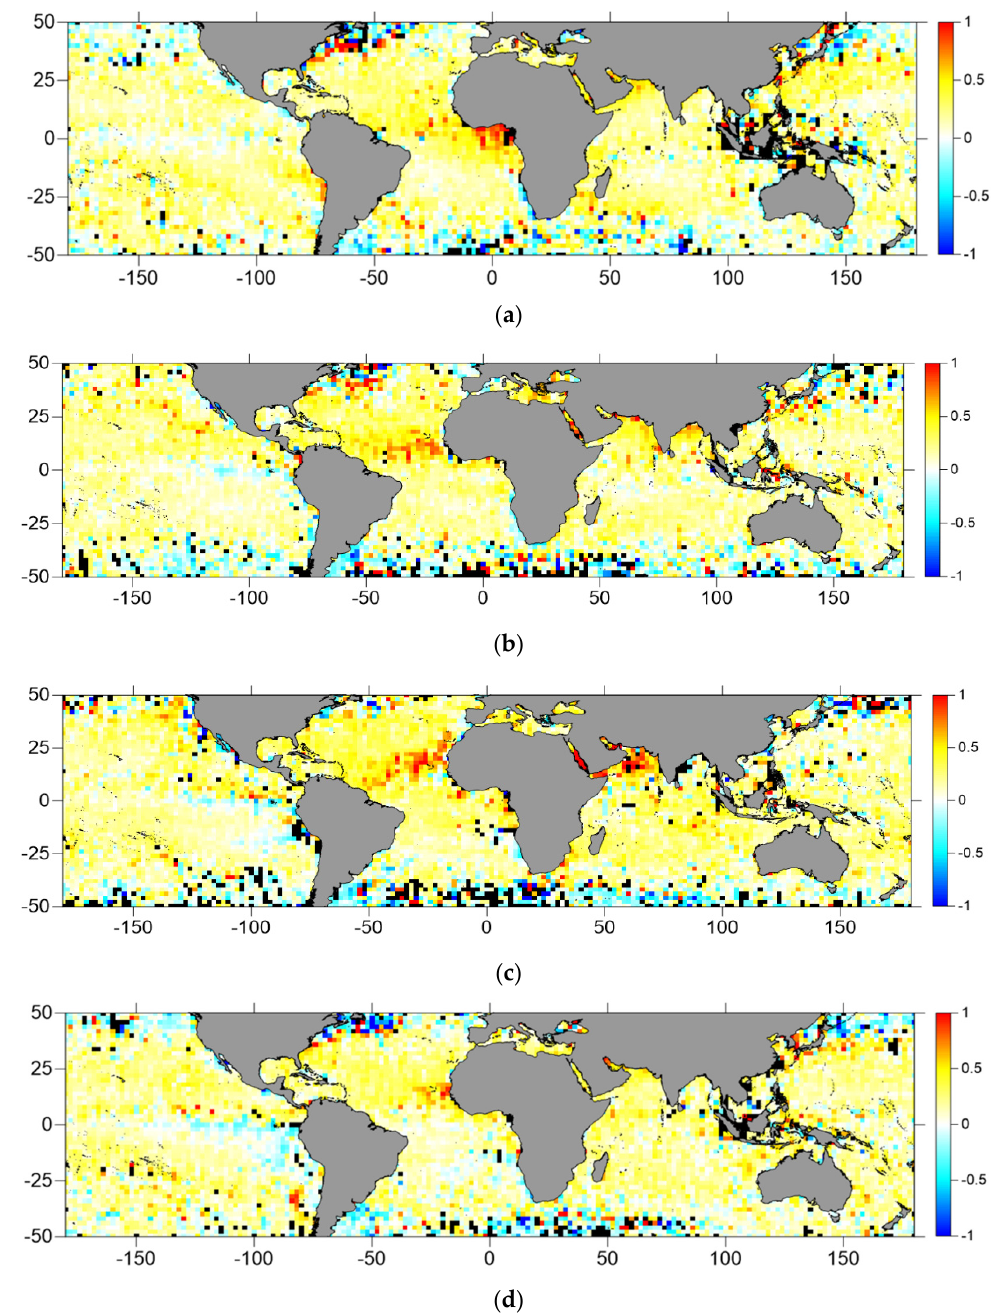
Figure 1. Maps of the mean SST skin differences, in K, between the Sentinel-3A SLSTR sensor and the ERA5 atmospheric model (SST SLSTR ₋ SST ERA5 ), derived for Sentinel-3A SRAL cycles 13, 17, 21 and 24 (subpanels ( a – d ), respectively), represented with a 2° by 2° spatial resolution. Blank pixels are shown in black.